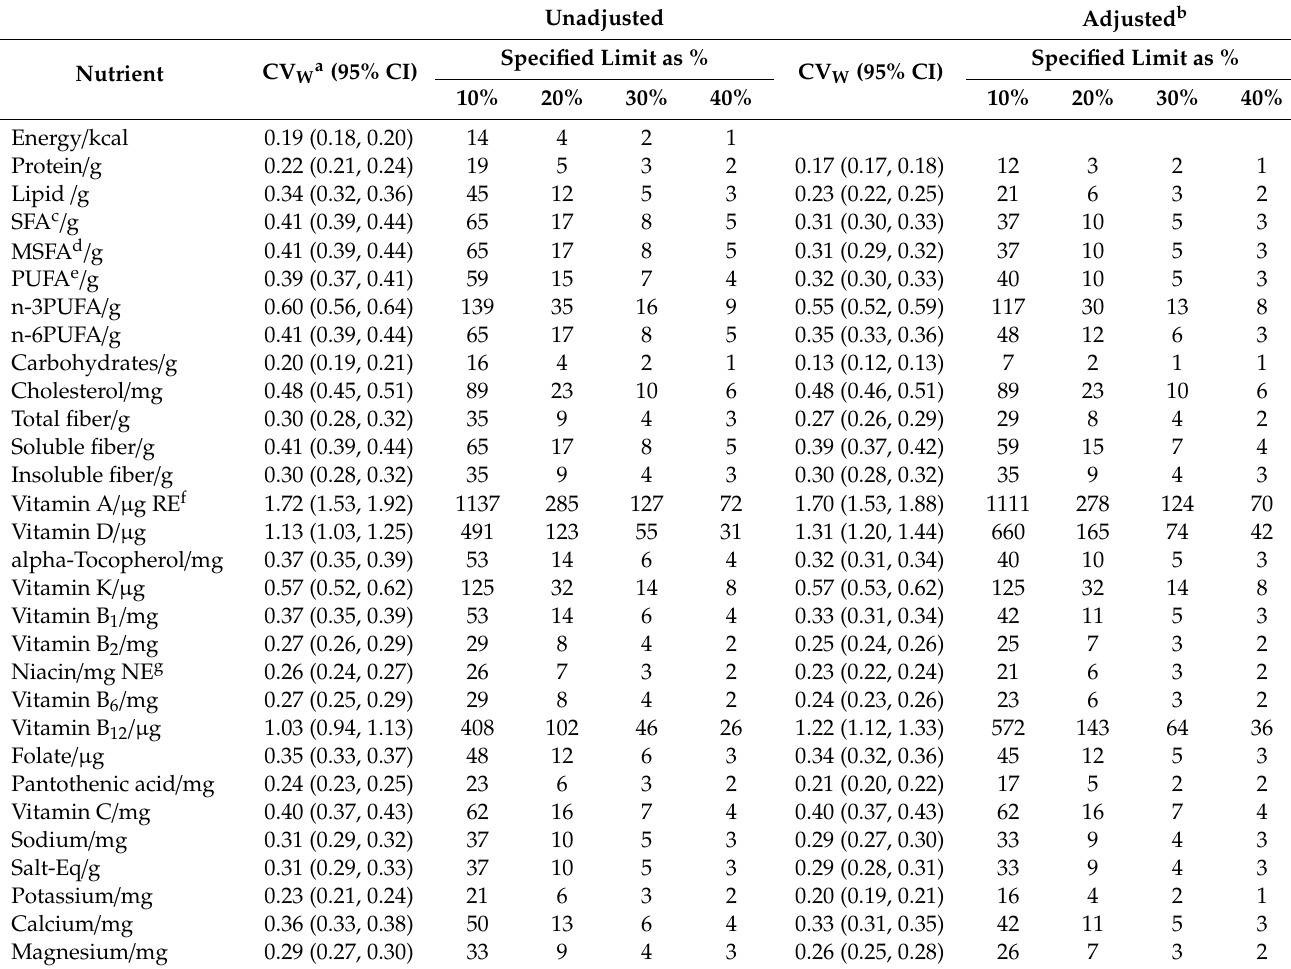
Table 2. Coe ffi cients of within-person variation (CV W ) and the number of days required to estimate the true intakes of unadjusted- and adjusted-nutrients to lie within specified % of true means (data provided by 131 residents in